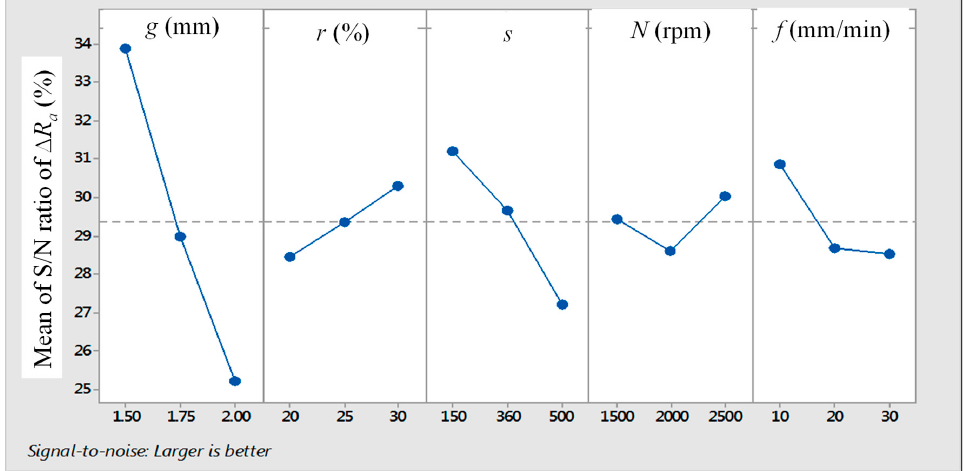
Figure 6. S/N ratio plots of ∆ R a (%) for Al 2 O 3 abrasive ( g = working gap, r = percentage of abrasive, s = abrasive mesh number, N = spindle speed, and f = feed rate).